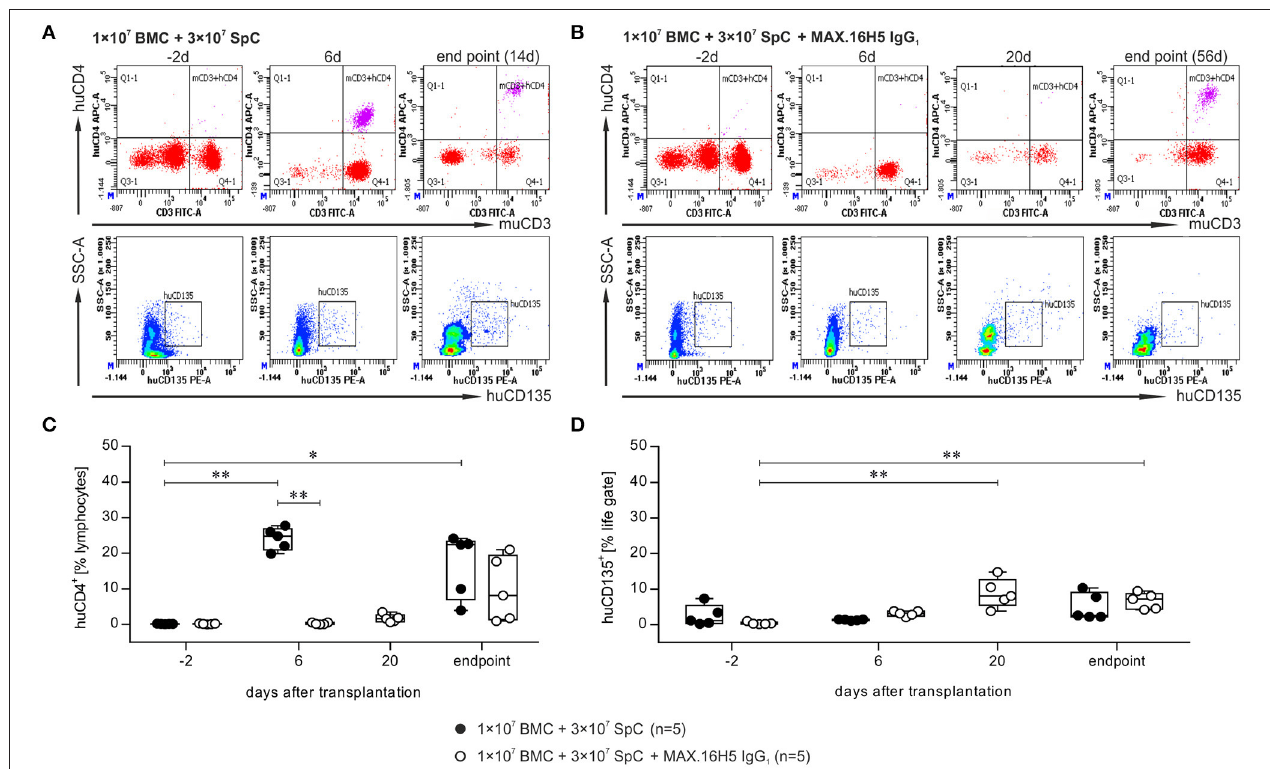
FIGURE 2 | Flow cytometric analysis of the immune reconstitution (murine CD3 + /human CD4 + ) as well as tumor growth (human CD135 + ) after transplantation of bone marrow and spleen cell grafts either pre-incubated with MAX.16H5 IgG 1 or without antibody pre-treatment. All recipient animals received 1 × 10 7 bone marrow cells (BMC) and 3 × 10 7 splenocytes (SpC) in these experiments. (A,B) Representative plots obtained from flow cytometric analyses after transplantation of (A) one animal with untreated or (B) one animal with MAX.16H5 IgG 1 pre-treated grafts at different time points (in (A) : day − 2, day 6, endpoint; in (B) : day − 2, day 6, day 20, endpoint) using specific antibodies against murine CD3/human CD4 or human CD135. In the lower rows, human CD135 + signals are depicted together with side-scattered light signals. (C) Human CD4 + events as percentages of lymphocyte gates in the blood samples of recipient mice. Every symbol indicates one animal at a defined time point. Engraftment and proliferation of human CD4 + cells were detected in five out of five animals receiving an untreated graft and in three out of five animals receiving the MAX.16H5